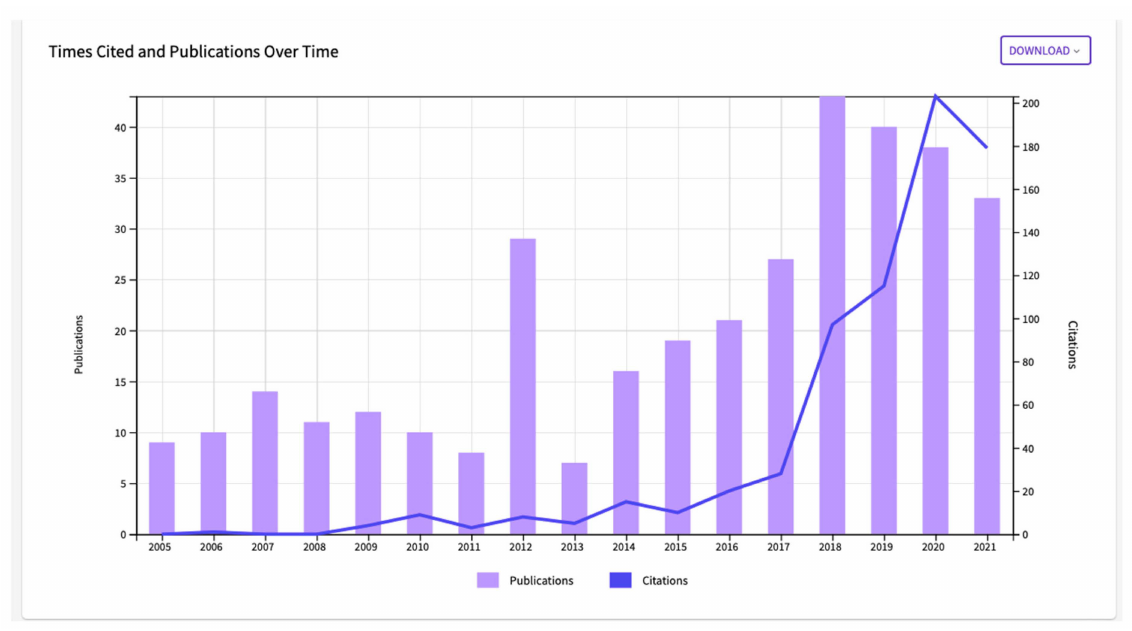
Figure 12. Citations vs. number of publications per year of the analysed journal in the period